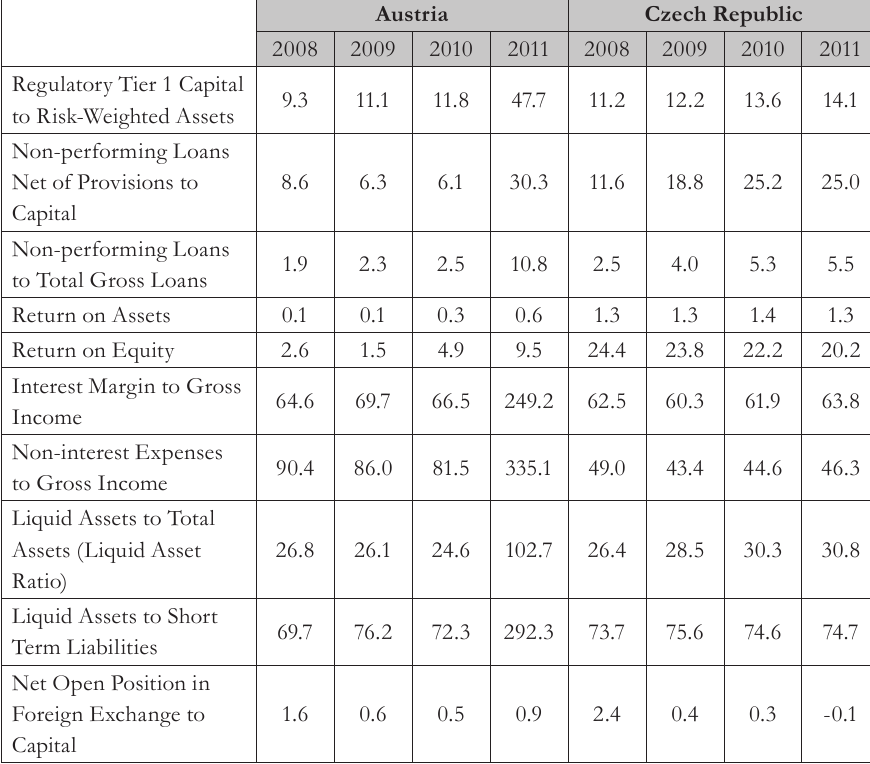
Tab. 1 – Bank sector indicators. Source: International Monetary